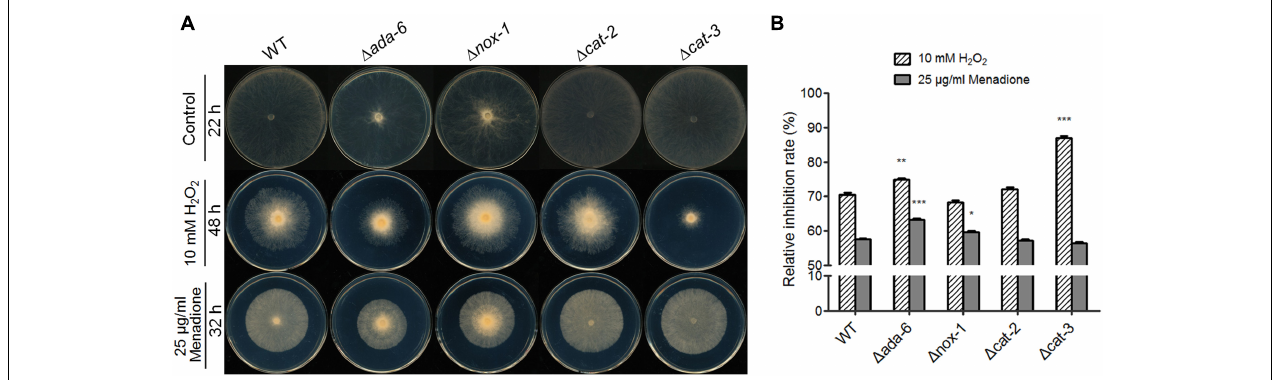
FIGURE 4 | Susceptibility test of N. crassa wild type and knockout mutants ( ada-6 , nox-1 , cat-2 , and cat-3 ) to oxidants. (A) Susceptibility test of the strains to oxidants. Wild type and the mutants were inoculated in φ 90-mm plates (containing 15-ml liquid Vogel’s medium) and allowed to grow at 28 ◦ C in darkness for 24 h. The mycelial mat were punched and the round mat with φ 4-mm were inoculated in the center of plates ( φ -90 mm) with or without oxidant (H 2 O 2 or menadione), and incubated at 28 ◦ C for indicated time, respectively. Each test was duplicated and the experiment was independently repeated at least three times. (B) Relative growth inhibition rates were calculated based on colony diameters after 22 h of incubation. Values from three replicates were used for a statistical analysis. Means of the inhibition rates are shown, and standard deviations are marked with error bars. Differences between the mutants and the WT were statistically analyzed by the analysis of variance. Values with P < 0.001, 0.001 < P < 0.01, and 0.01 < P < 0.05 are marked with ∗∗∗ , ∗∗ , and ∗ ,